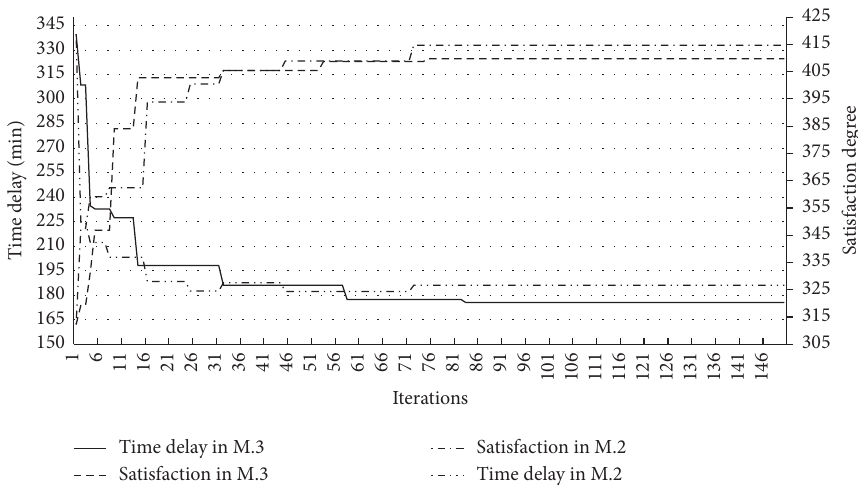
Figure 12: The convergence graph of M.2 compared with process of the M.3 .